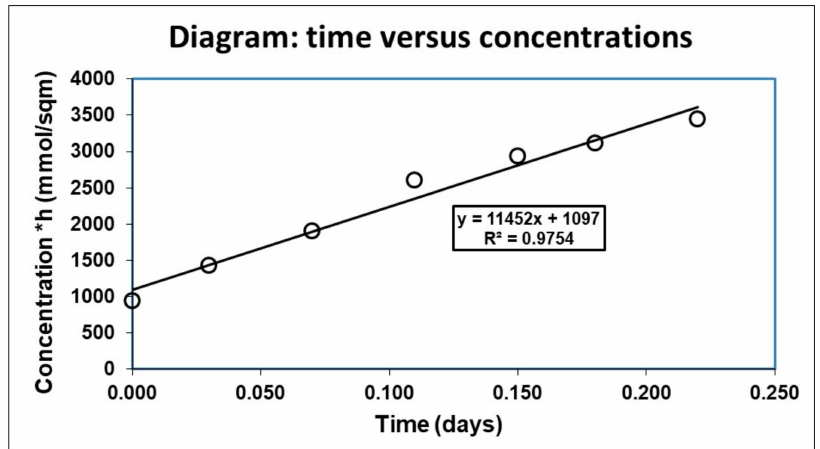
Figure 15. Diagram illustrating the time of water sample collection in the benthic chamber against its concentration and the correlation